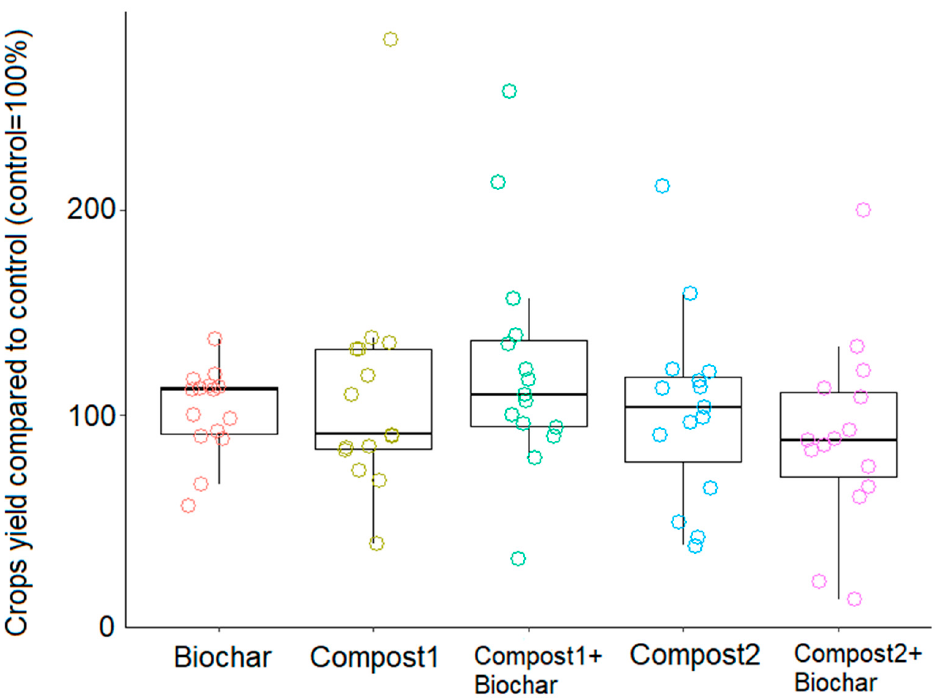
Figure 1. Overall crops yield compared to the control (100%) for each of the five applied treatments during two years of growth. The lower and upper bounds of the boxplots show the first and third quartiles (the 25th and 75th percentiles), the middle line shows the median, whiskers above and below the boxplot indicate inter-quartile range, and points beyond the whiskers indicate outlying points. Table 3. Soil chemical parameters after one and two years of organic amendment application. Different letters within each column indicate significantly different groups (Duncan test, p < 0.05).